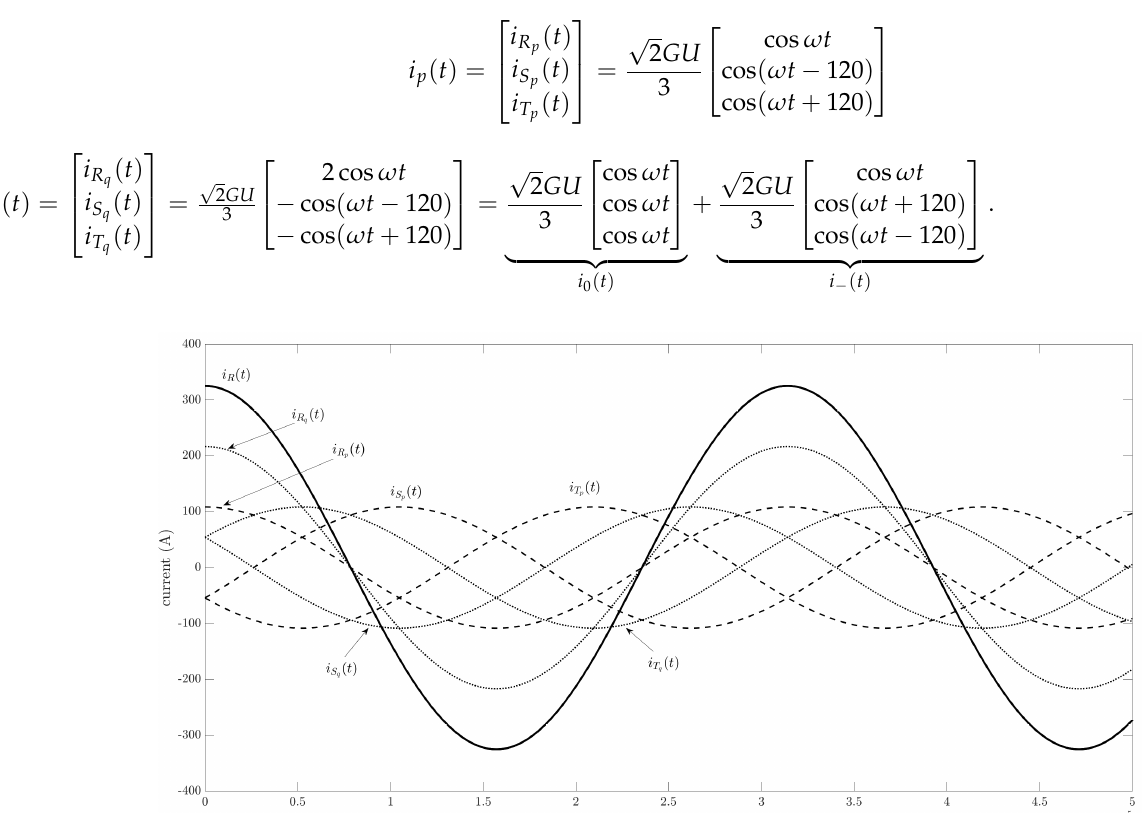
Figure 5. Current decomposition for the three-phase circuit. The very unbalanced system of currents (solid line) can be decomposed in 3 symmetrical sets of currents, i p , i 0 and i −